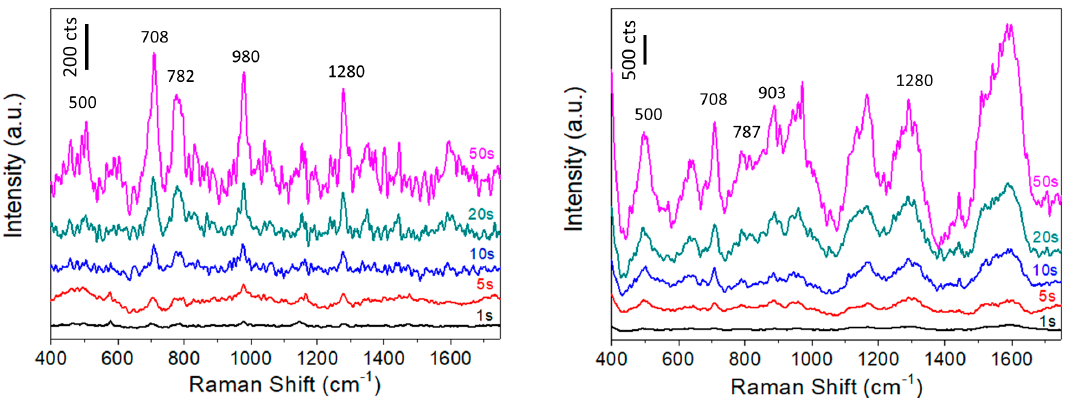
Figure 7. SERS response of Glass_Ag_AuNPs ( left ) and Glass_AuNPs ( right ) samples upon exposure to DMMP vapor (1.2 ppmV) as a function of integration time. Acquisition conditions: 50×, 5 mW.